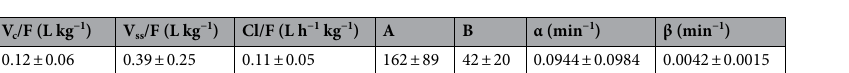
Table 2. Milrinone PK parameters after fitting a two-compartment model with zero-order input to individual data. All values are mean (standard deviation). A coefficient of biexponential equation describing distribution curve, B coefficient of biexponential equation describing elimination curve, Cl total body clearance, F bioavailability, PK pharmacokinetic,